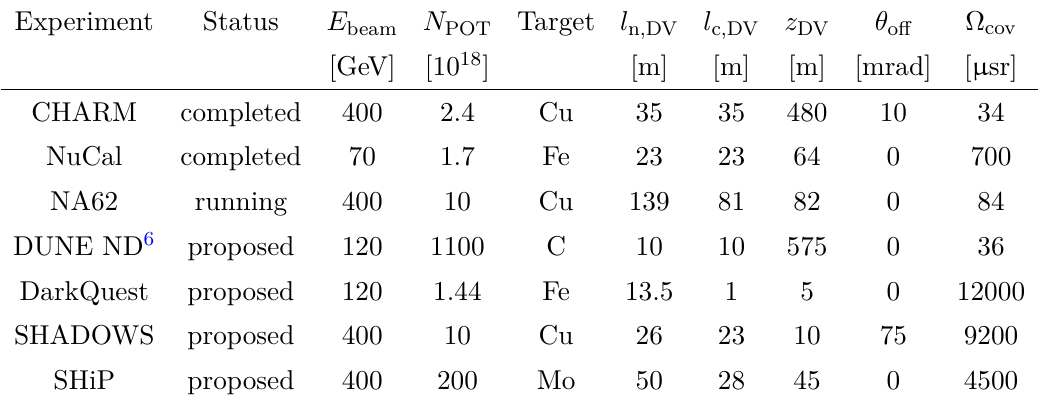
Table 2 . Overview of the basic parameters for the experimental setups considered in this work. See text for details and